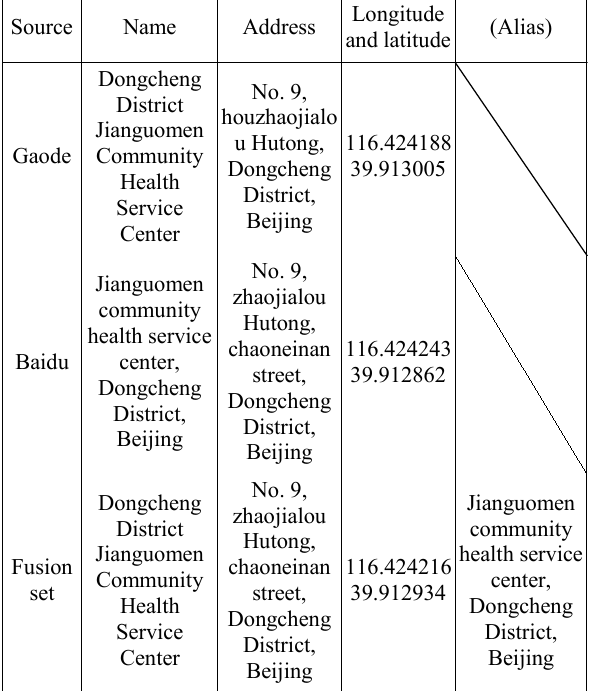
Table 4. Example of matching set fusion